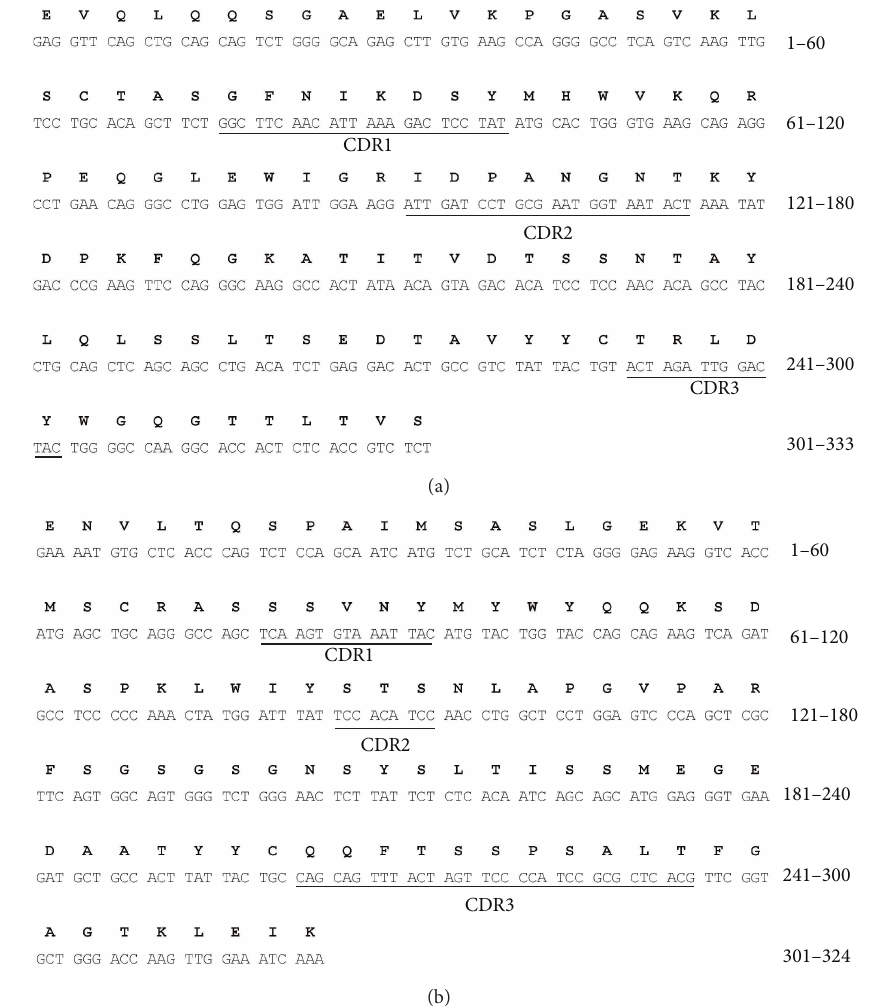
Figure 2: Nucleotide and deduced amino acid sequences of V H and V L . The CDRs are underlined based on the analysis of VBASE2 database. (a) Nucleotide sequence of V H and deduced amino acid sequence of V H . (b) Nucleotide sequence of V L and deduced amino acid sequence of V L